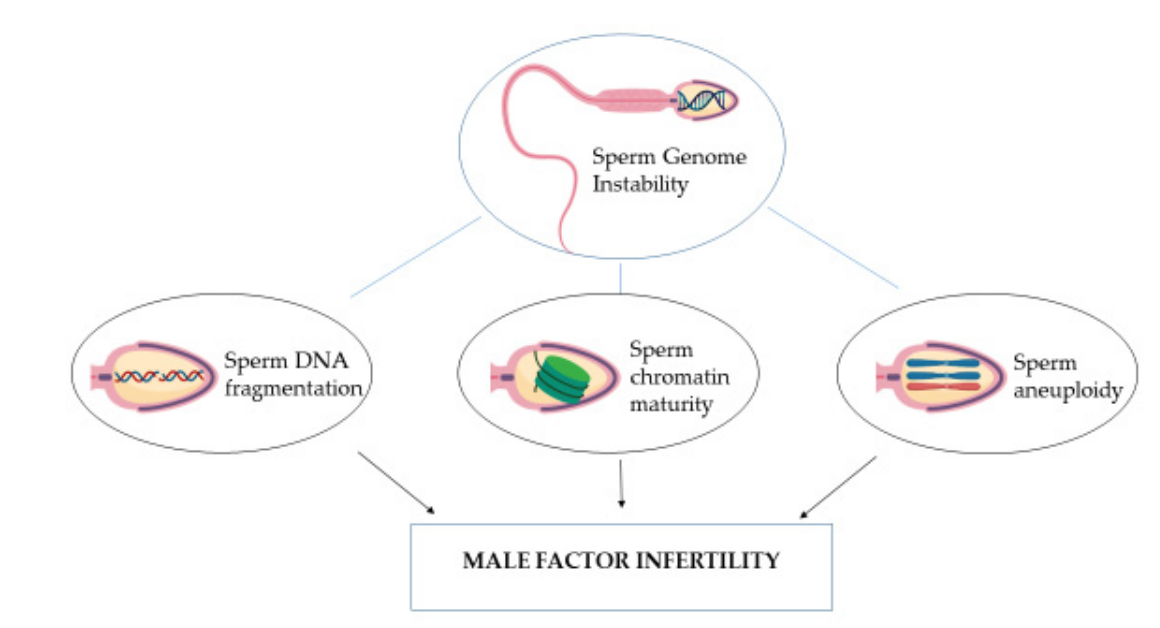
Figure 1. Schematic representation of genome instability assessment in male factor infertility. Figure created with BioRender.com.